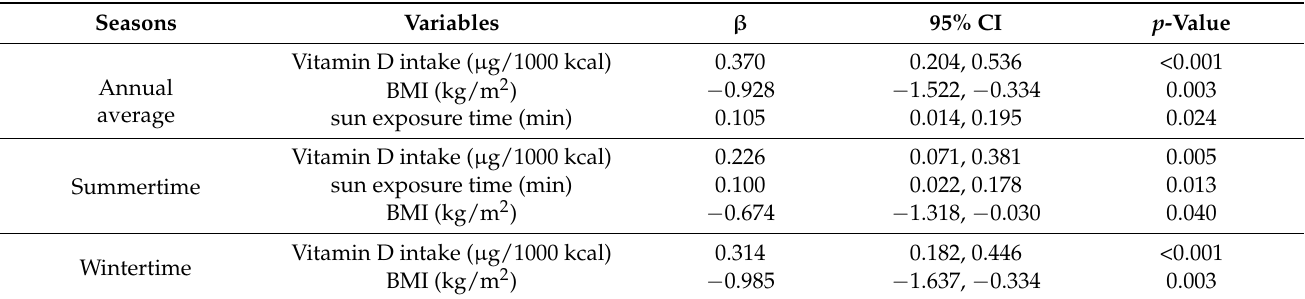
Table 5. Multivariate linear regression analyzing the factors influencing the serum 25(OH)D level by season.